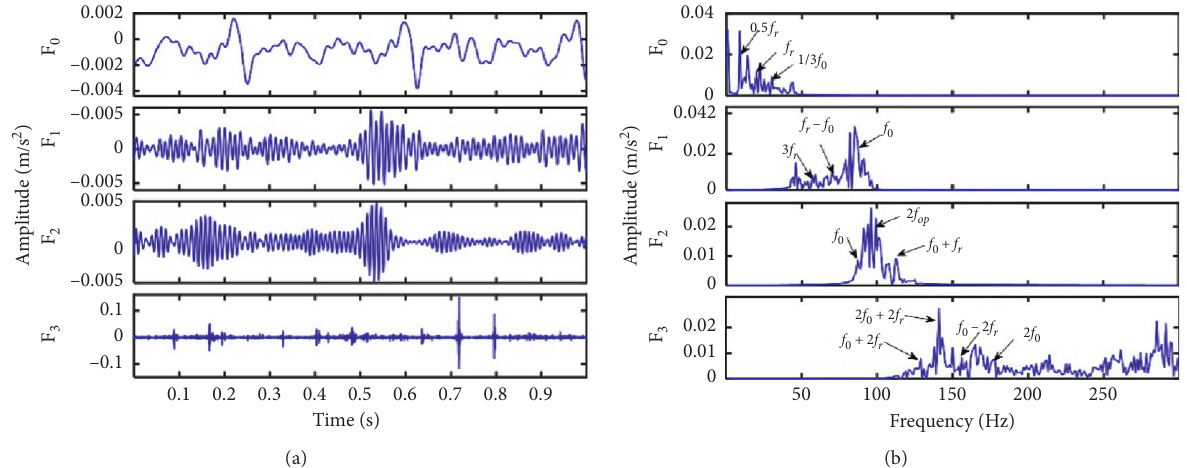
Figure 9: Outer race fault characteristics: (a) modal components of the outer race fault signal using EWT and (b) the spectrum of modal components.